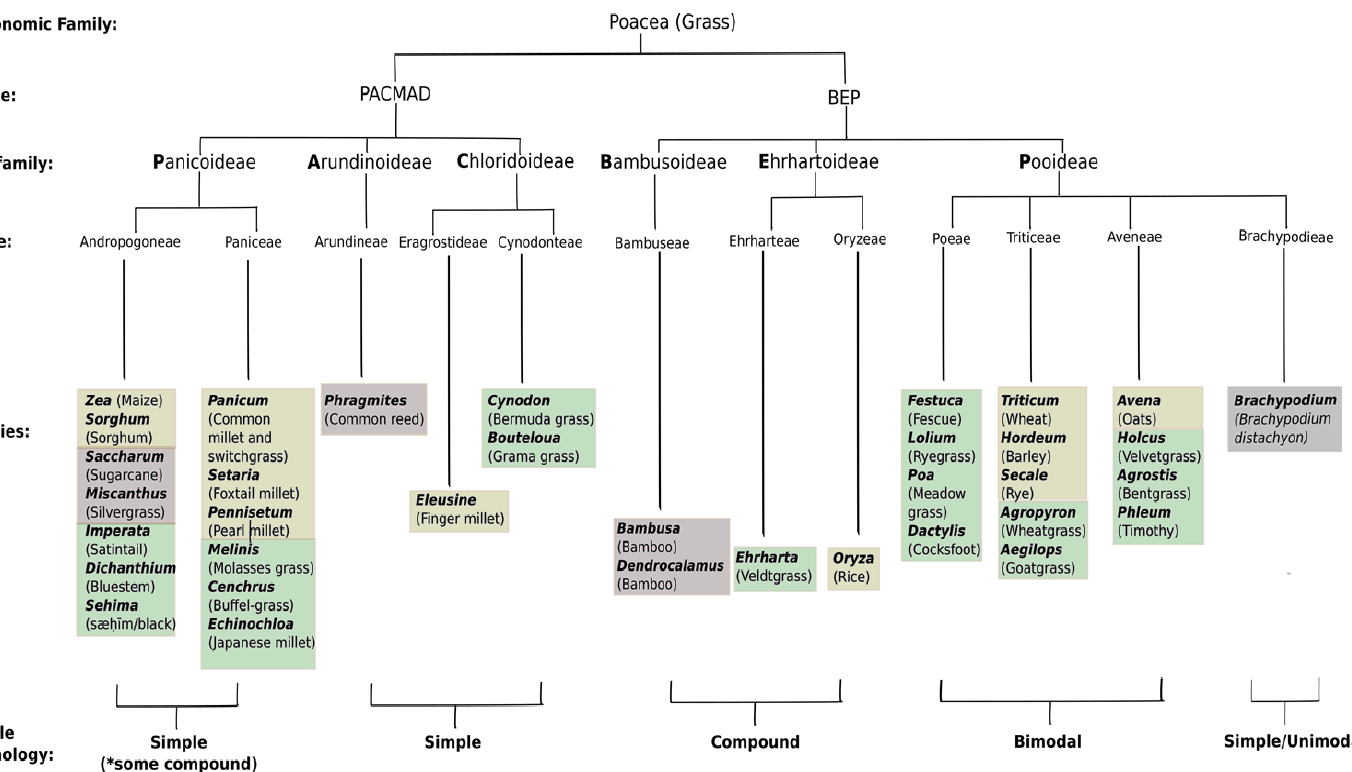
Figure 1. Major starch producing cereals of the world and their relationship to other agriculturally important Poaceae (grass) species. The grass family, clade, subfamilies, tribe, and species are shown on the top, and the starch granule morphology type in the endosperm on the bottom. The compound starch granule type in the endosperm is thought to represent the ancestral state. Grass species are grouped according to their major agronomic utility; yellow: cereals, green: forage grasses, brown: non-forage crops harvested for vegetative biomass, purple: model organisms. Note that many cereals are also grown as forage. Common names for respective major species members are given below in parentheses. * Some primitive Panicoid grasses, e.g., Sorghum italica , show compound granules (the presumptive ancestral starch granule morphology). PACMAD: clade representing the Panicoideae, Aristidoideae, Chloridoideae, Micrairoideae, Arundinoideae, and Danthonioideae; BEP: clade representing the Bambusoideae, Ehrhartoideae, and Pooideae.